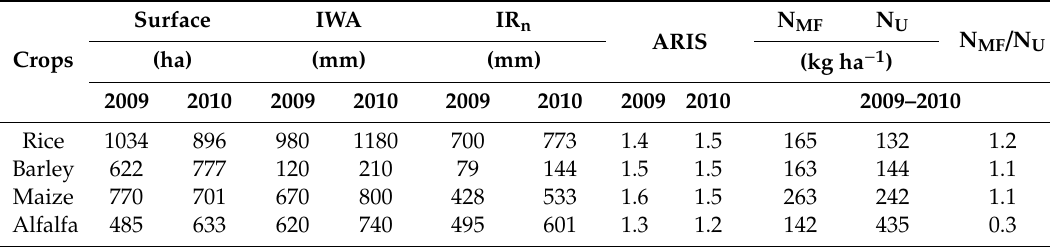
Table 1. Surface, irrigation water applied (IWA), seasonal net irrigation requirements (IR n ), annual relative irrigation supply index (ARIS), mineral nitrogen fertilizer (N MF ), crop nitrogen uptake (N U ) and relationship between applied mineral nitrogen and that used by the crops (M NF / N U ) for the main irrigated crops in the Clamor Vieja basin in 2009 and